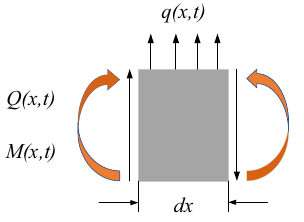
Figure 6 Model of equivalent beam microelement segment